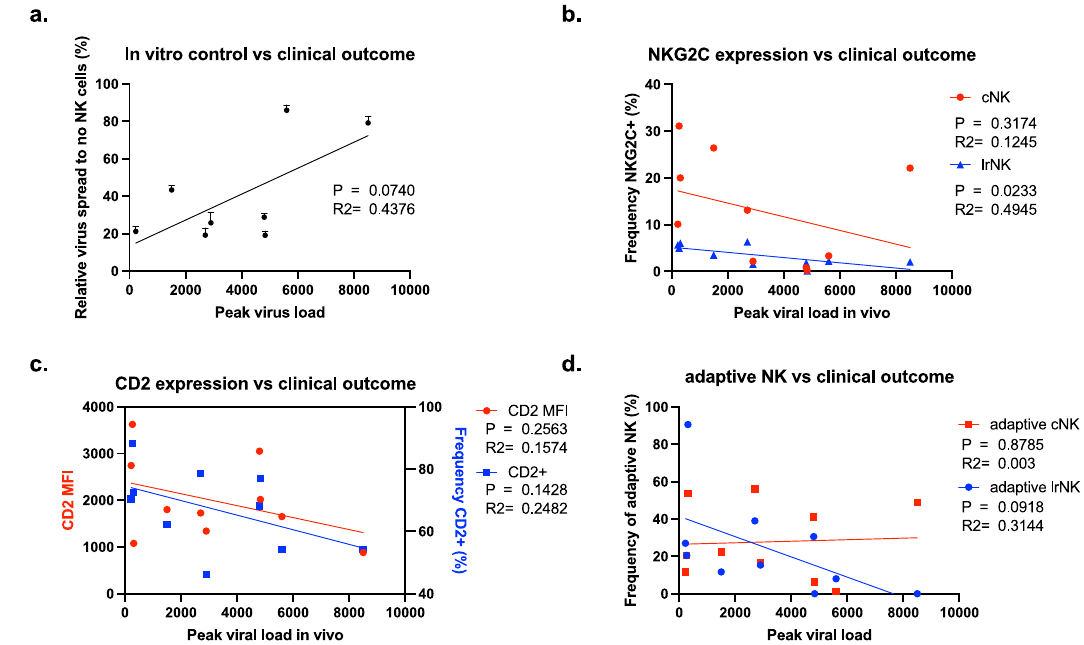
Fig. 4 | Increased frequency of ‘ adaptive ’ lrNK cells correlates with better outcomepost-transplant. Peakviralload(genomecopies/mlblood)within1year post-transplant in all transplant recipients who received a liver from a HCMV- seropositive donor is plotted against ( a ) in vitro control of HCMV spread by lrNK cells (black; n =8). Expression of NKG2C+cNK (red) or lrNK (blue) cells ( b ), lrNK